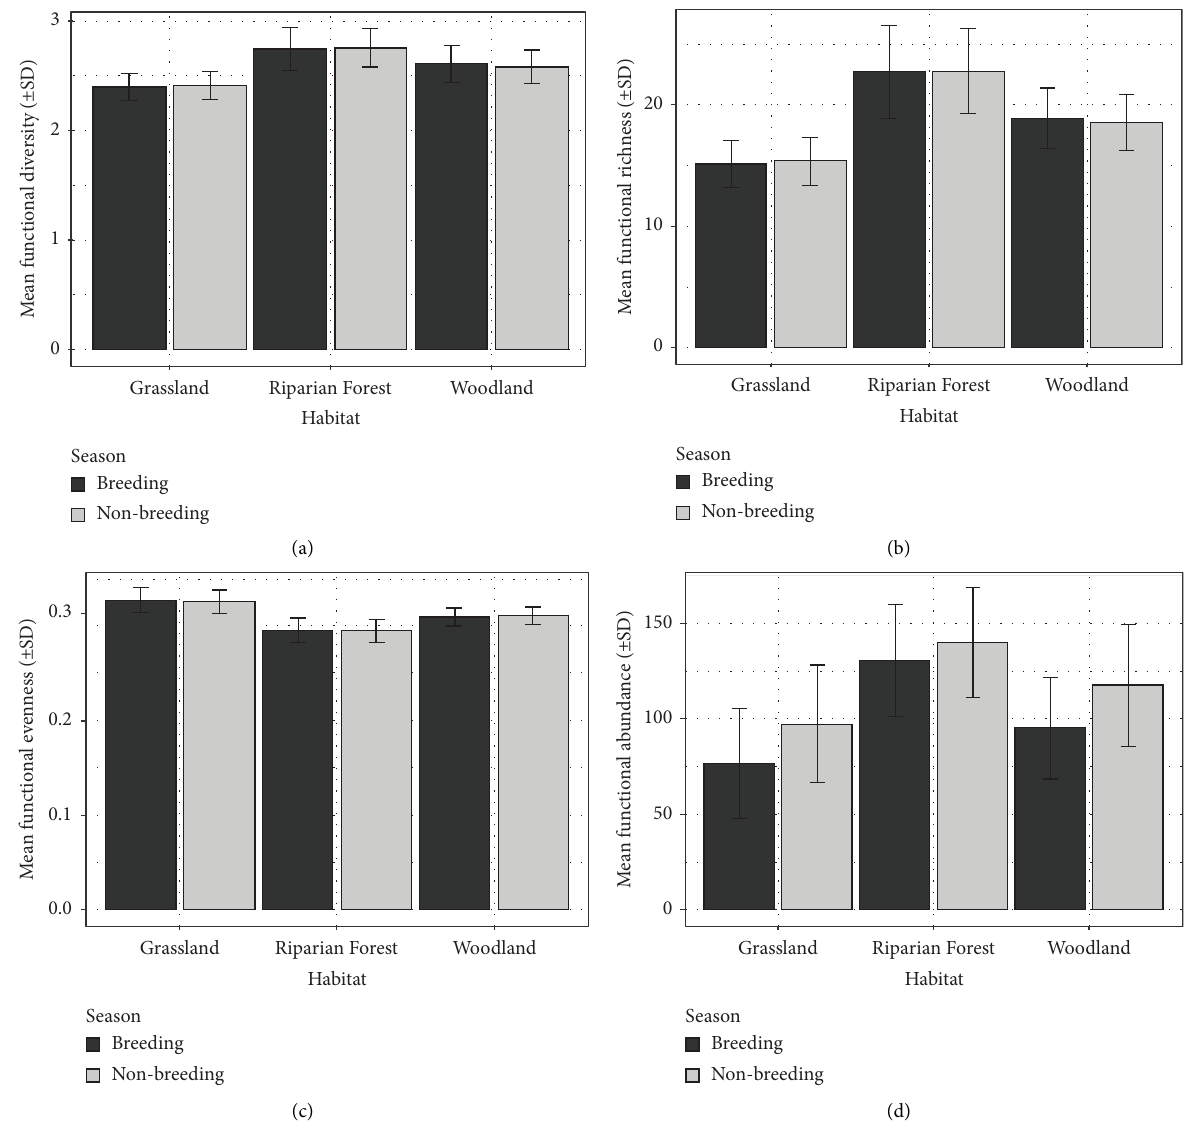
Figure 4: Mean variations in avifaunal functional diversity indicators among three habitat types in the MNP. ((a) Functional diversity, (b) functional evenness, (c) functional richness, and (d) functional